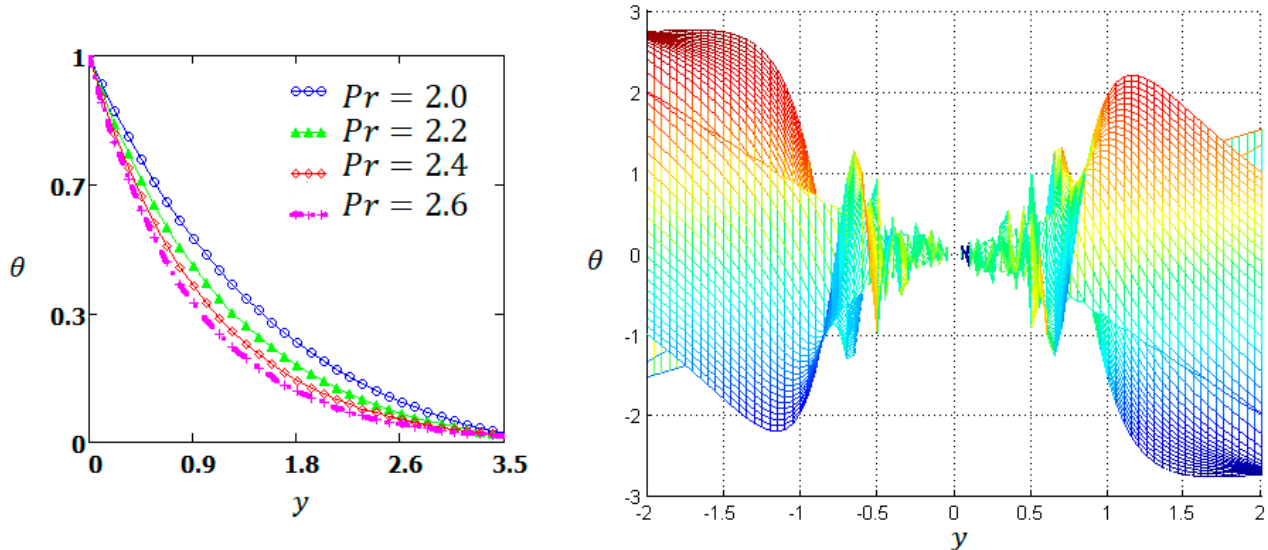
Figure 3. Temperature distribution with ripple visualization verses non-ripple visualization for 2-D graphs subject to varying Pr.